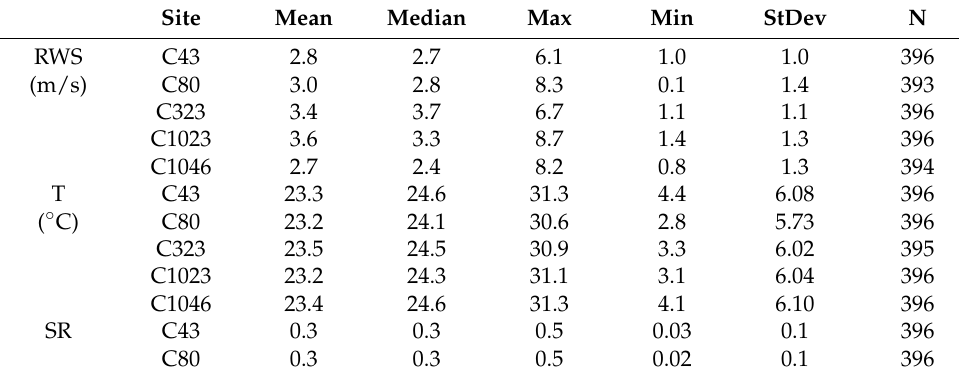
Table 1. Summary statistics of 24 h meteorological parameters from CAMSs.